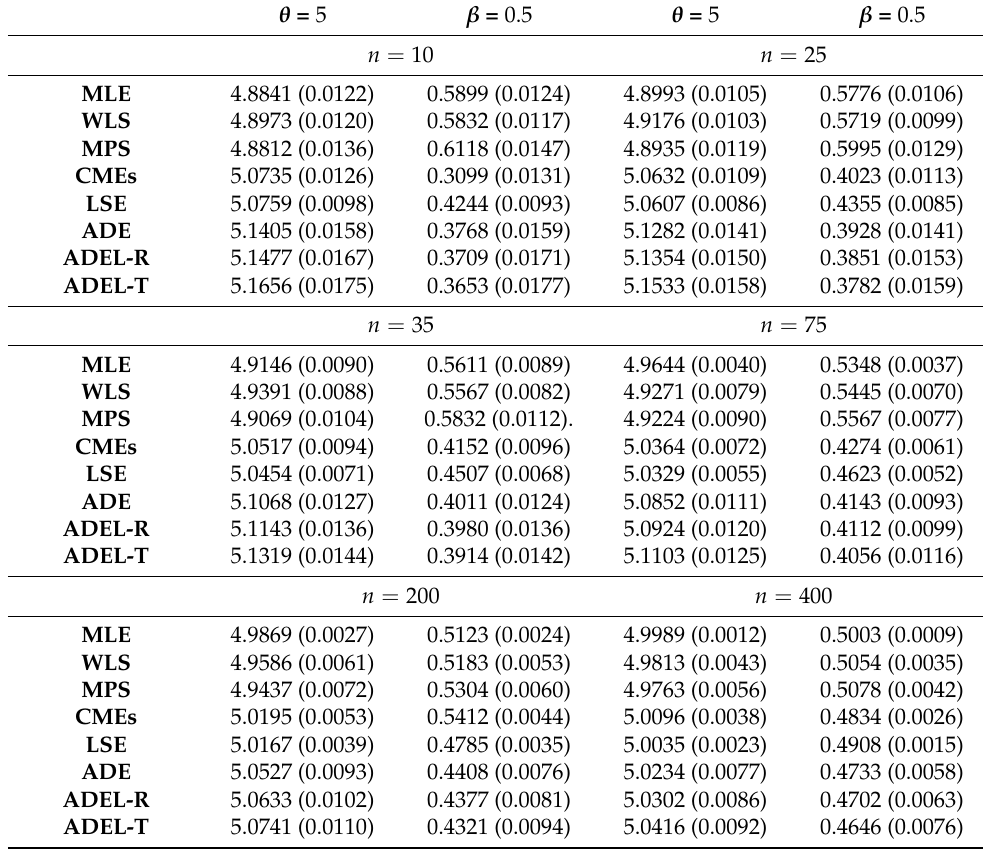
Table 3. Estimators’ values of θ = 5 and β = 0.5 with different estimation